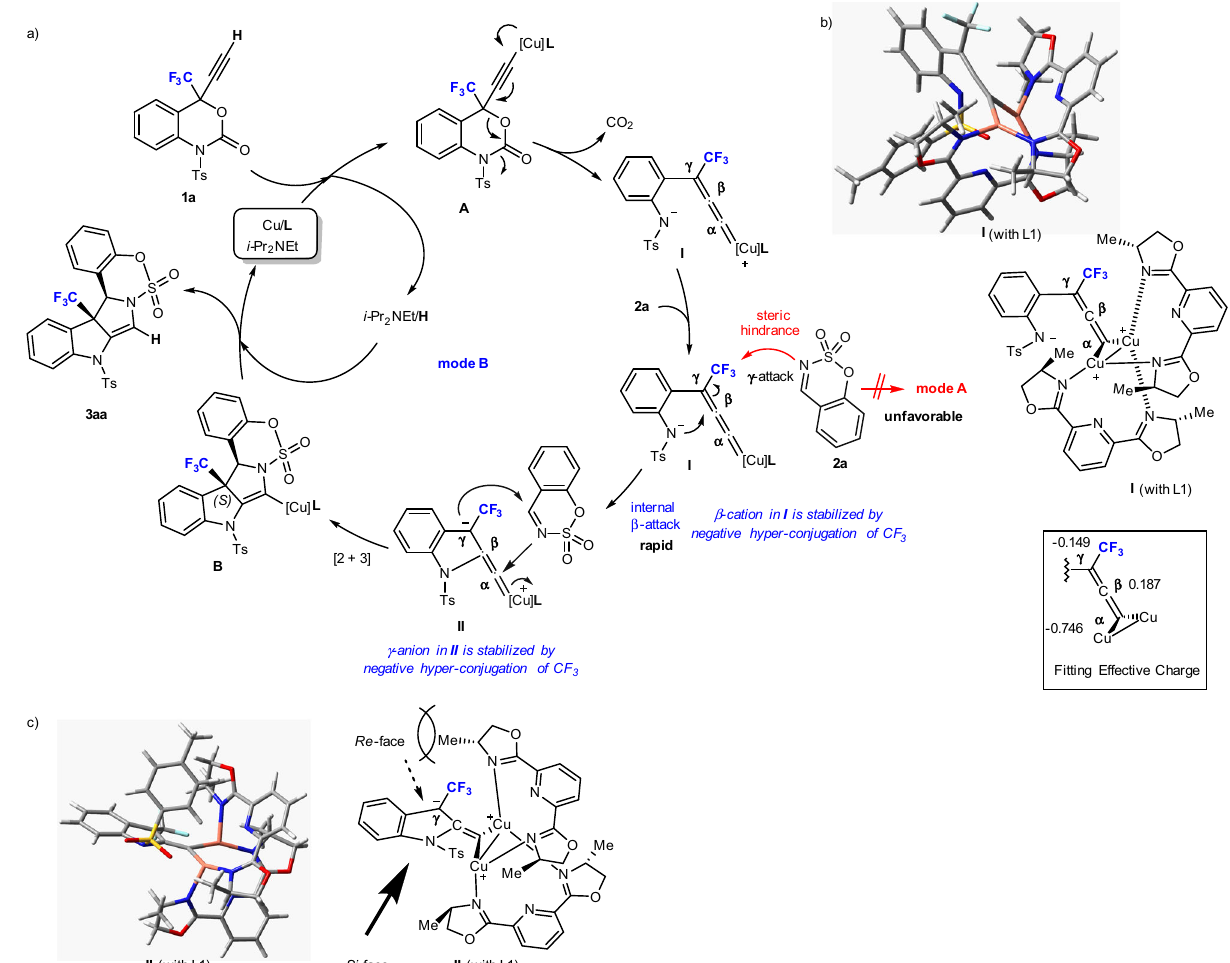
Fig. 7 A proposed reaction mechanism. a A Cu-catalyzed catalytic cycle for the decarboxylative annulation of 1a with 2a (mode B) . b Optimized geometry of I (with L1 ) and calculated atomic charges. c Optimized geometry of II (with L1 ) and stereochemical model rationalizing the observed